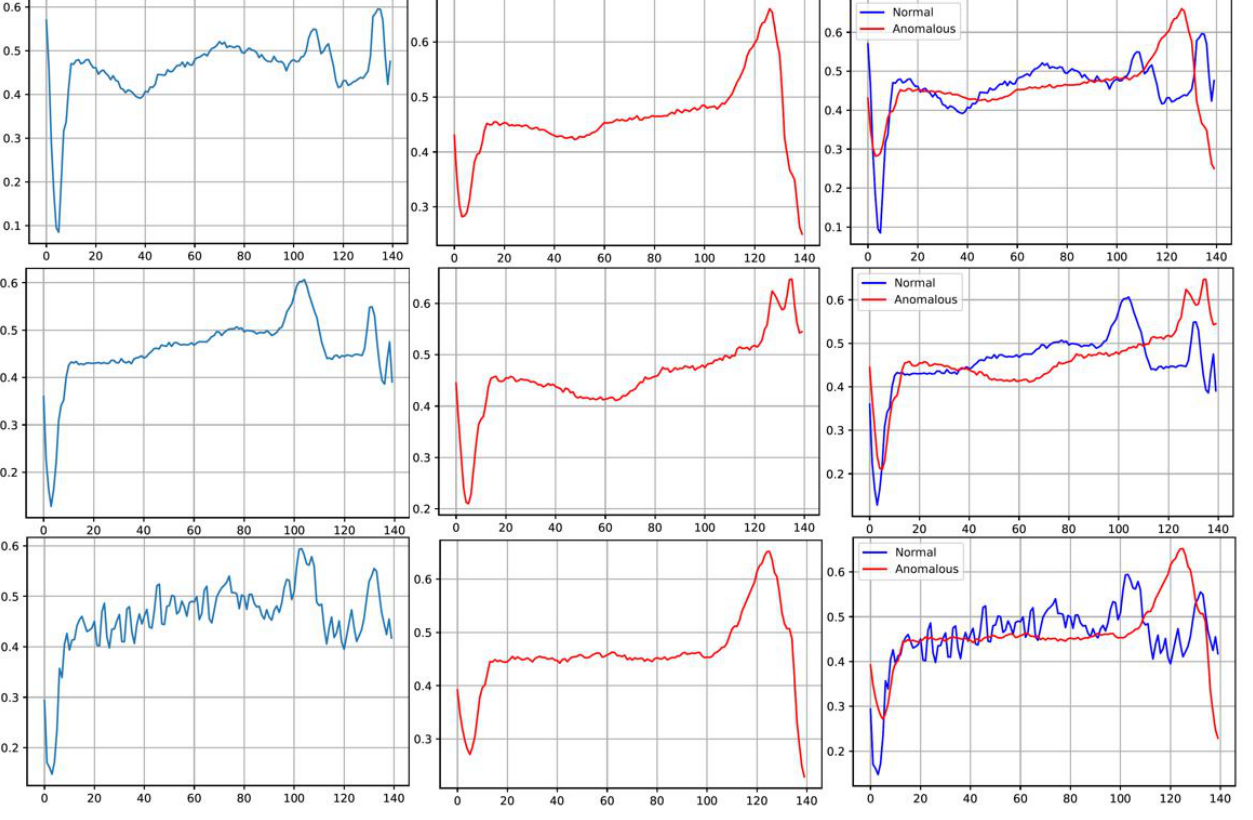
Figure 1. Temporal distribution of normal and abnormal heartbeat from the ECG5000 dataset. Left column : Normal heartbeat; Middle column : Anomalous heartbeat; Right column : Combination of normal and anomalous